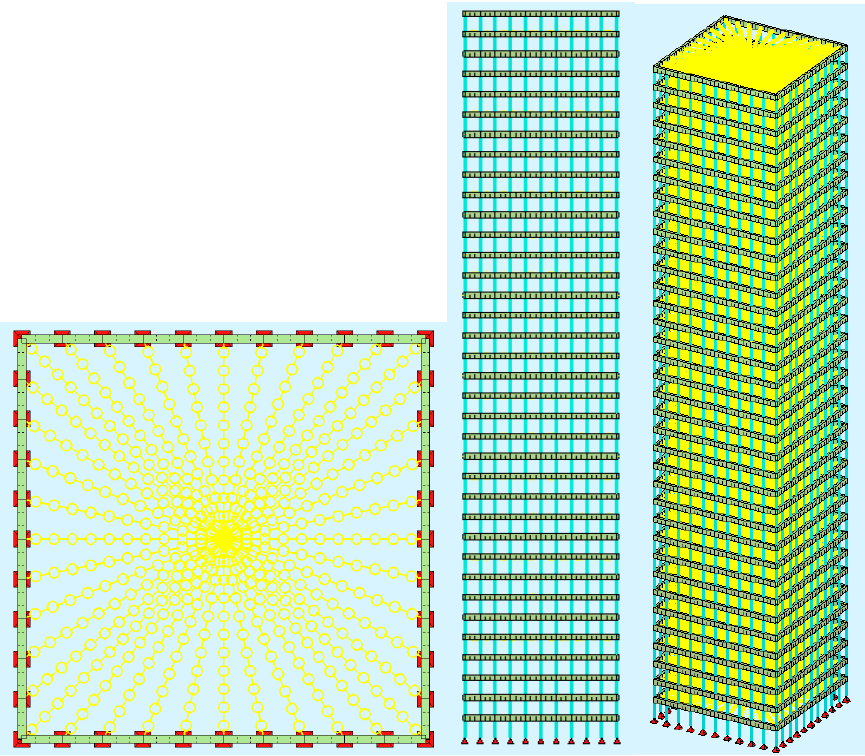
Figure 5. The floor layout, side view and the axonometry of the computer model (red—pinned supports at the location of columns, green—beams, yellow—rigid diaphragm, light blue—col- umns).